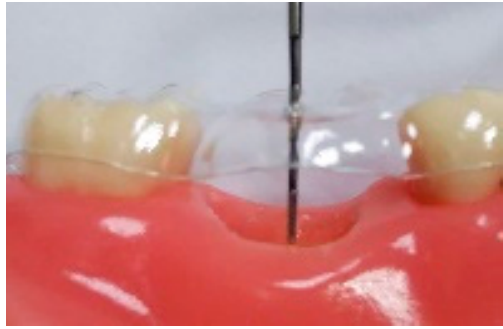
Figure 3. Changes in the alveolar ridge. Alveolar ridge height measurement.